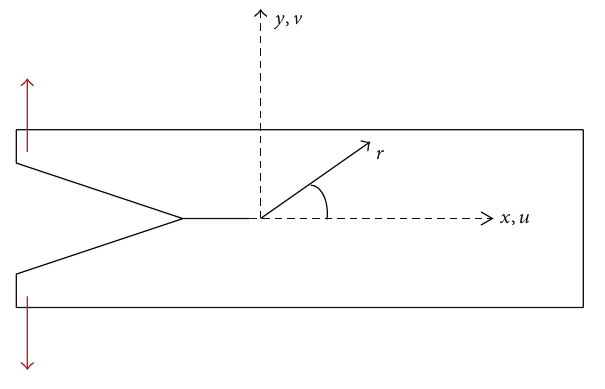
Figure 4: Crack opening